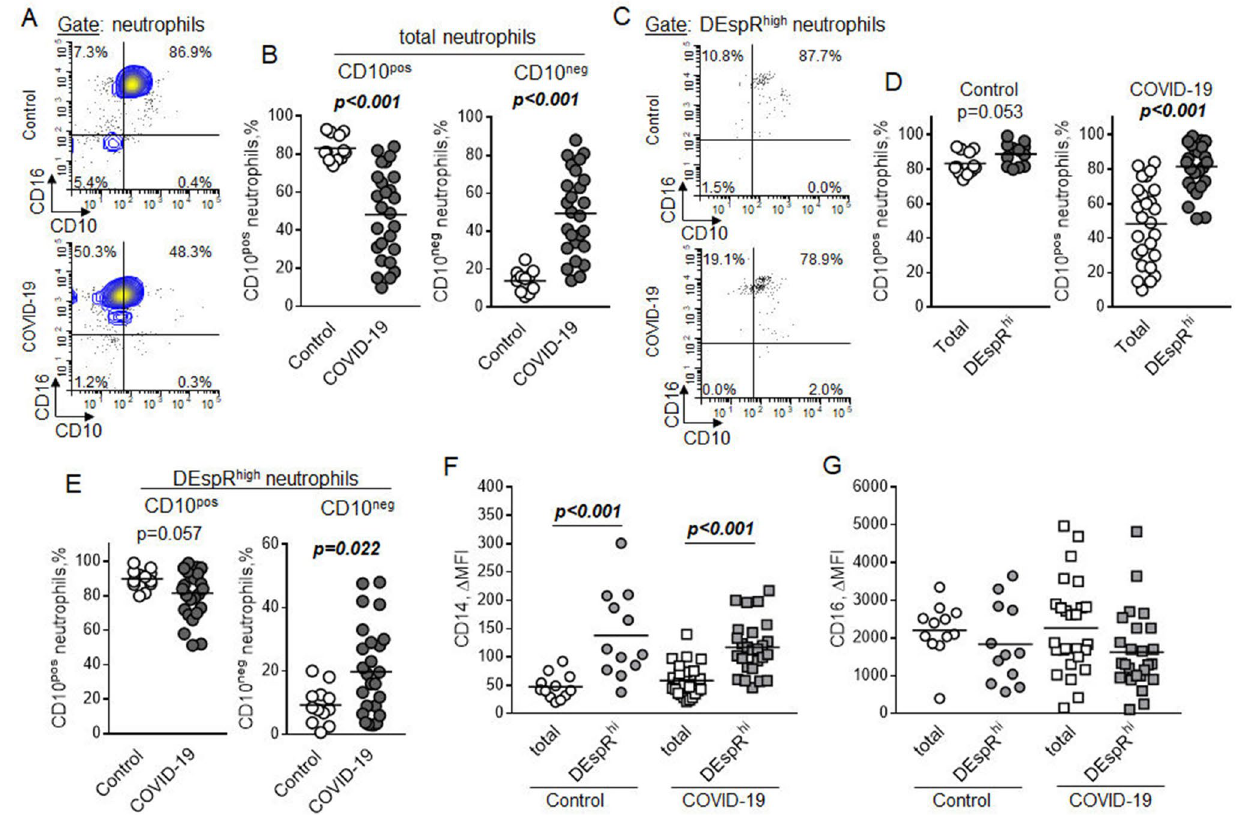
Figure 2. Expression of CD10, CD14, and CD16 on DEspR high neutrophils in control subjects and COVID- 19 patients. The expression of cell surface markers was determined in the subpopulation of peripheral blood SSC high neutrophils ( total neutrophils ) or a subset of neutrophils with high expression of DEspR ( DEspR high neutrophils ) in control ( n = 12) and COVID-19 ( n = 26) subjects. ( A ) Representative flow cytometric plots showing expression of CD10 on total neutrophils in control (upper) and COVID-19 (lower) subjects. ( B ) Number of CD10 positive (left) and CD10 negative neutrophils. Mann–Whitney test. ( C ) Flow cytometric plots demonstrating expression of CD10 on DEspR high neutrophils in control (upper) and COVID-19 (lower) subjects. ( D ) Percentage of CD10 positive cells in a subpopulation of total neutrophils (Total) or a subset of DEspR high neutrophils in control (left) and COVID-19 (right) subjects. Mann–Whitney test. ( E )